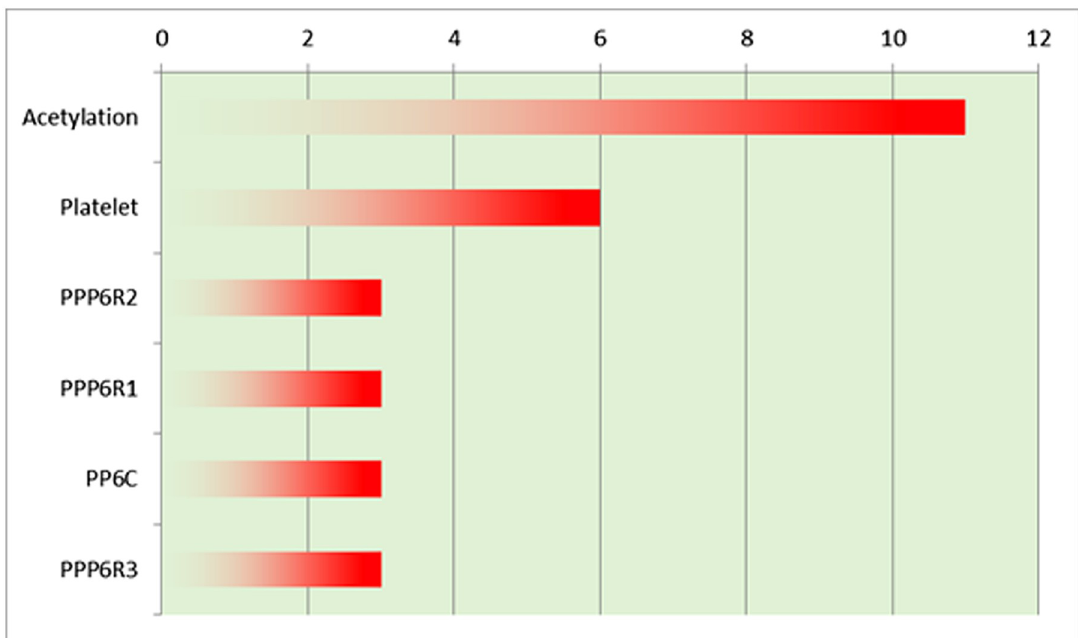
Fig 7. DAVID analysis on stage 3 breast cancer samples.